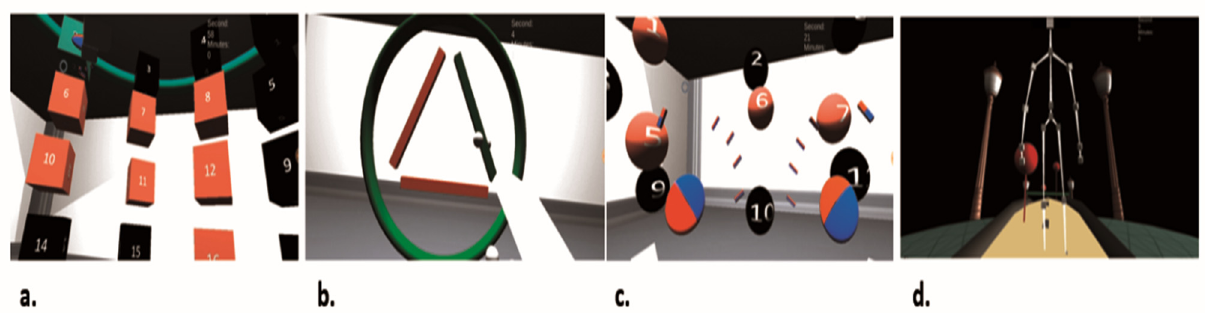
Figure 2. Visual interfaces for AR rehabilitation tasks: ( a ) Accuracy domain: motor domain focused on the movement accuracy of the upper limb; ( b ) Statics domain: motor domain focused on the static–dynamic load of muscles of the upper limb; ( c ) Capture domain: motor domain focused on the capture and compression of muscles of the hand; ( d ) Balance domain: motor domain focused on maintaining balance and overcoming obstacles when walking.